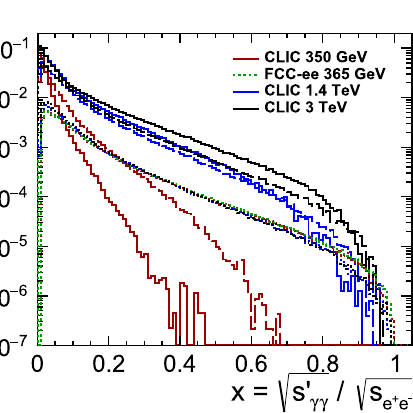
Fig. 3 The distributions of the γγ scattering centre-of-mass energy (cid:15) s (cid:11) γγ for FCC-ee at 365 GeV (green histogram) and for CLIC at 350 GeV, 1.4 TeV and 3 TeV (red, blue and black histograms, respectively). Inthelattercases,thesolidhistogramsshowthecollisionsoftwoBeam- strahlung photons, the dotted histograms the collisions of two EPA pho- tons and the dashed histograms the collisions of one Beamstrahlung and one EPA photon. All histograms at a given energy stage are scaled to the same run